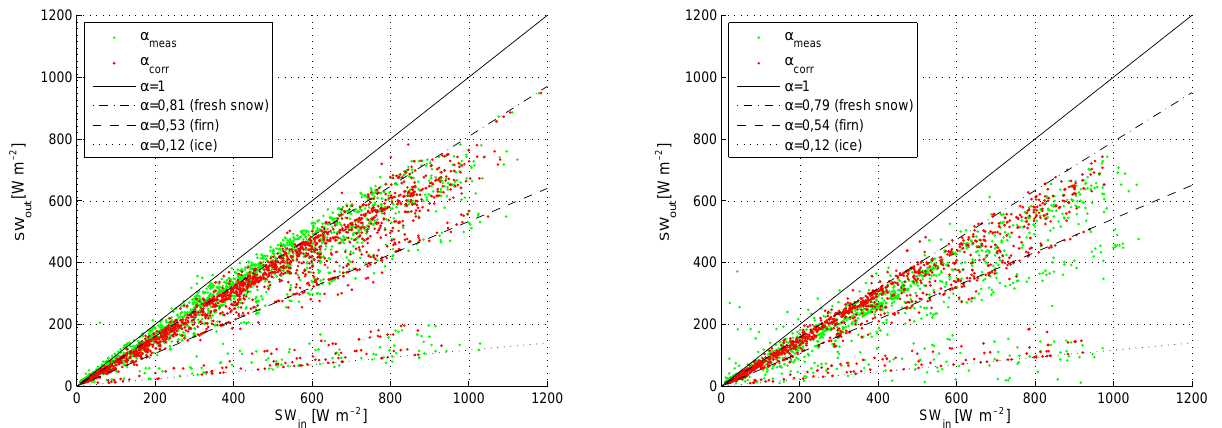
Figure 10. Measured (green) and corrected (red) albedo values on Kleinfleißkees (left) and Goldbergkees (right) for the years 2011 and 2012.